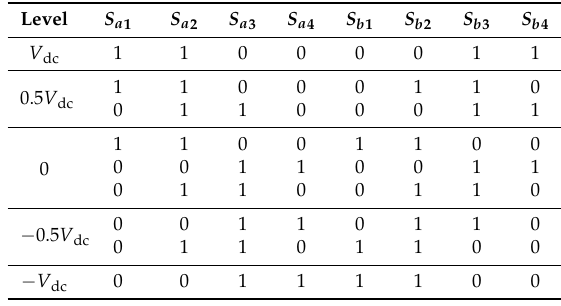
Table 1. Voltage level and switch mode.